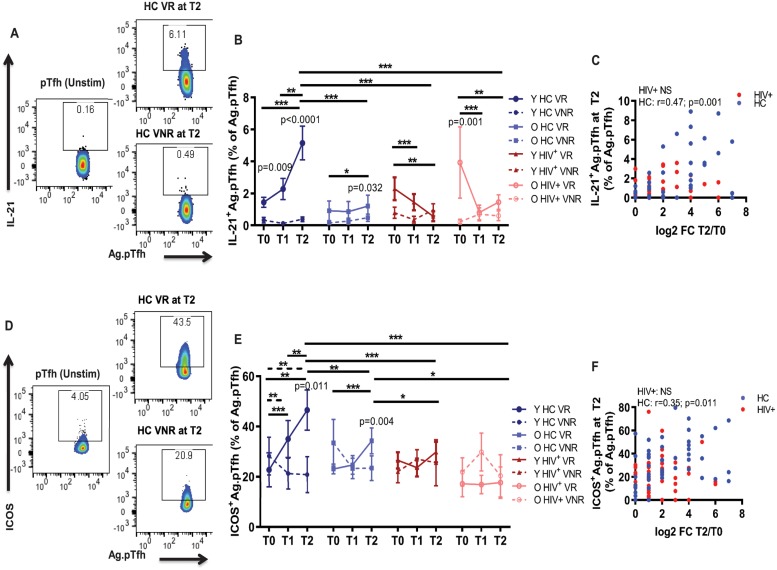
IL-21 and ICOS induction in Ag.pTfh cells are impaired in HIV+ groups.(A) Representative flow cytometry dot plots showing IL-21 expression within Ag.pTfh cells in a young HC VR and VNR at T2 post vaccination. (B) Line graph showing mean frequencies of IL-21+Ag.pTfh cells in the study groups. (C) Correlation between IL-21+Ag.pTfh cells at T2 and FC H1N1 Ab titer at T2 including VRs and VNRs together for HCs (blue) and HIV + individuals (red). (D) Representative flow cytometry plots showing ICOS+Ag.pTfh cells in a young HC VR and VNR. (E) Line graph showing mean frequencies of ICOS+Ag.pTfh cells in the study groups. (F) Correlation between ICOS+Ag.pTfh cells at T2 with FC H1N1 Ab titer at T2 including VRs and VNRs together for HCs (blue) and HIV+ individuals (red). Statistical analysis was performed to compare study groups and longitudinal analyses using generalized linear mixed models. Horizontal lines (solid for VR, dashed for VNR) indicate significant differences between time points within a group and between groups and the level of significance corresponds to p-values as follows: *p < 0.05; **p < 0.01; ***p < 0.001. p-Values shown within the graph refer to significant difference between VRs and VNRs at indicated time points. For correlation analyses, Spearman correlation coefficient was performed. Underlying data used in the generation of this figure can be found in S1 Data. Ab, antibody; Ag.pTfh, antigen-specific peripheral T follicular helper; FC, fold change; HC, healthy control; ICOS, inducible costimulator; IL-21, interleukin 21; O HC, old healthy control; O HIV+, old HIV+; Unstim, unstimulated cultures; VNR, vaccine nonresponder; VR, vaccine responder; Y HC, young healthy control; Y HIV+, young HIV+.